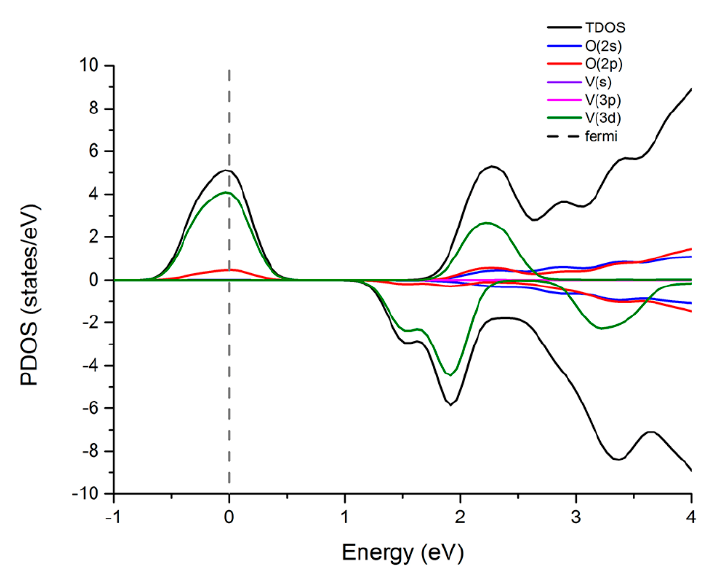
Figure 8. The local partial density of states (PDOS) curves ( − 1 to 4 eV).